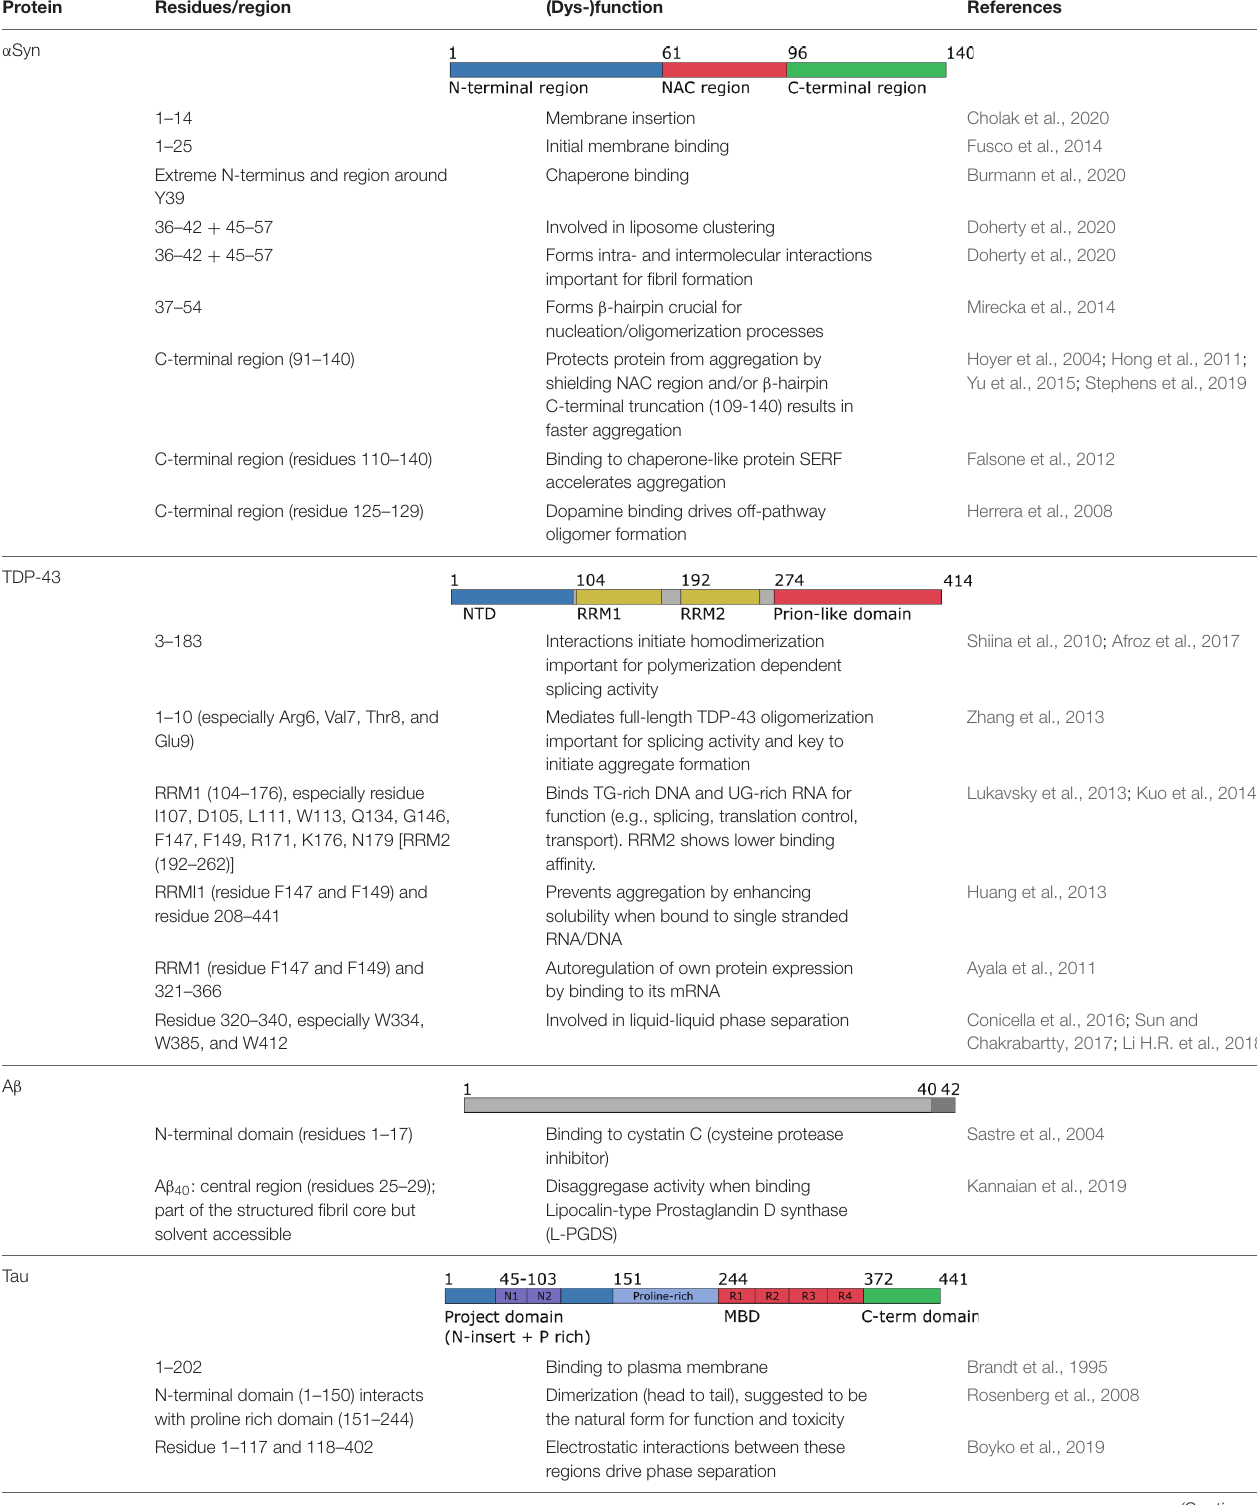
TABLE 1 | Summary of the functional roles of different regions of the amyloid proteins shown in Figure 3 . Protein